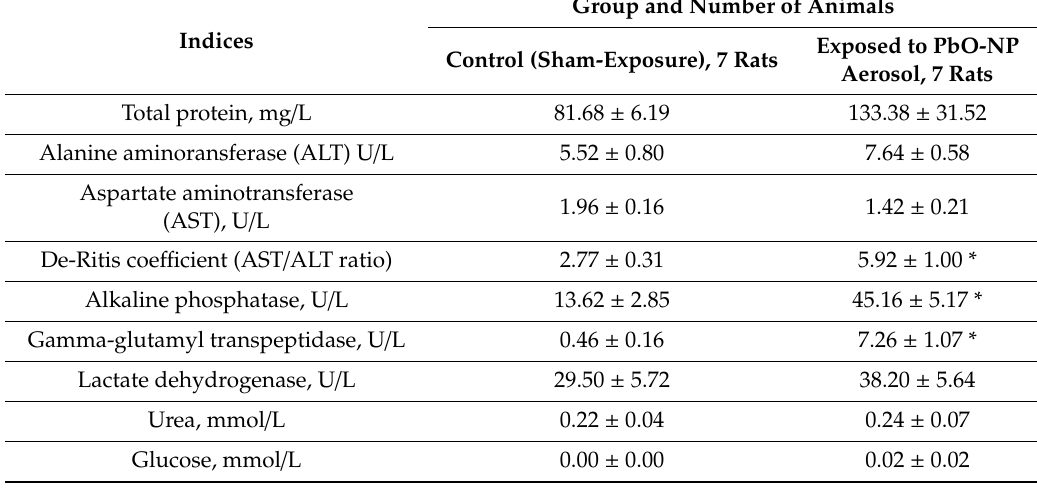
Table 2. Some biochemical indices in bronchoalveolar lavage fluid (BALF) supernatant in rats after repeated inhalation of lead oxide nanoparticles (x ± s.e.).